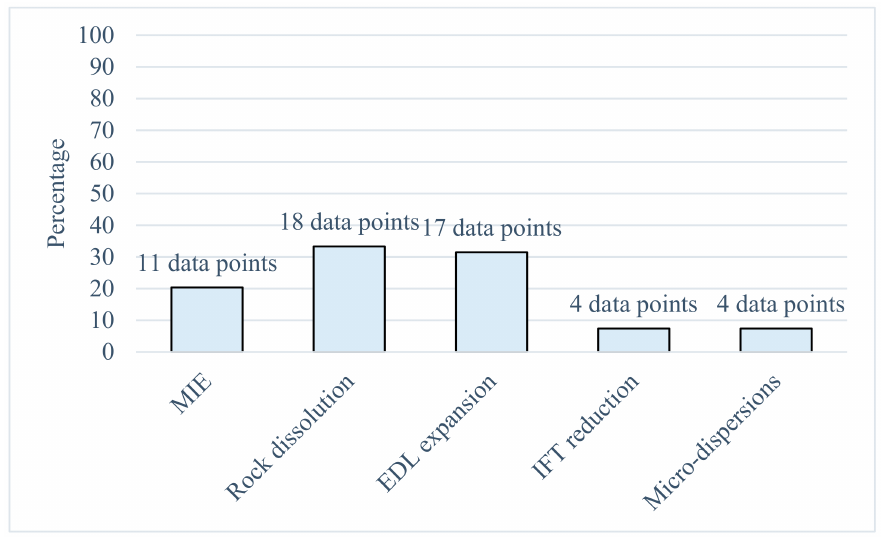
Figure 11. Number of data points for proposed